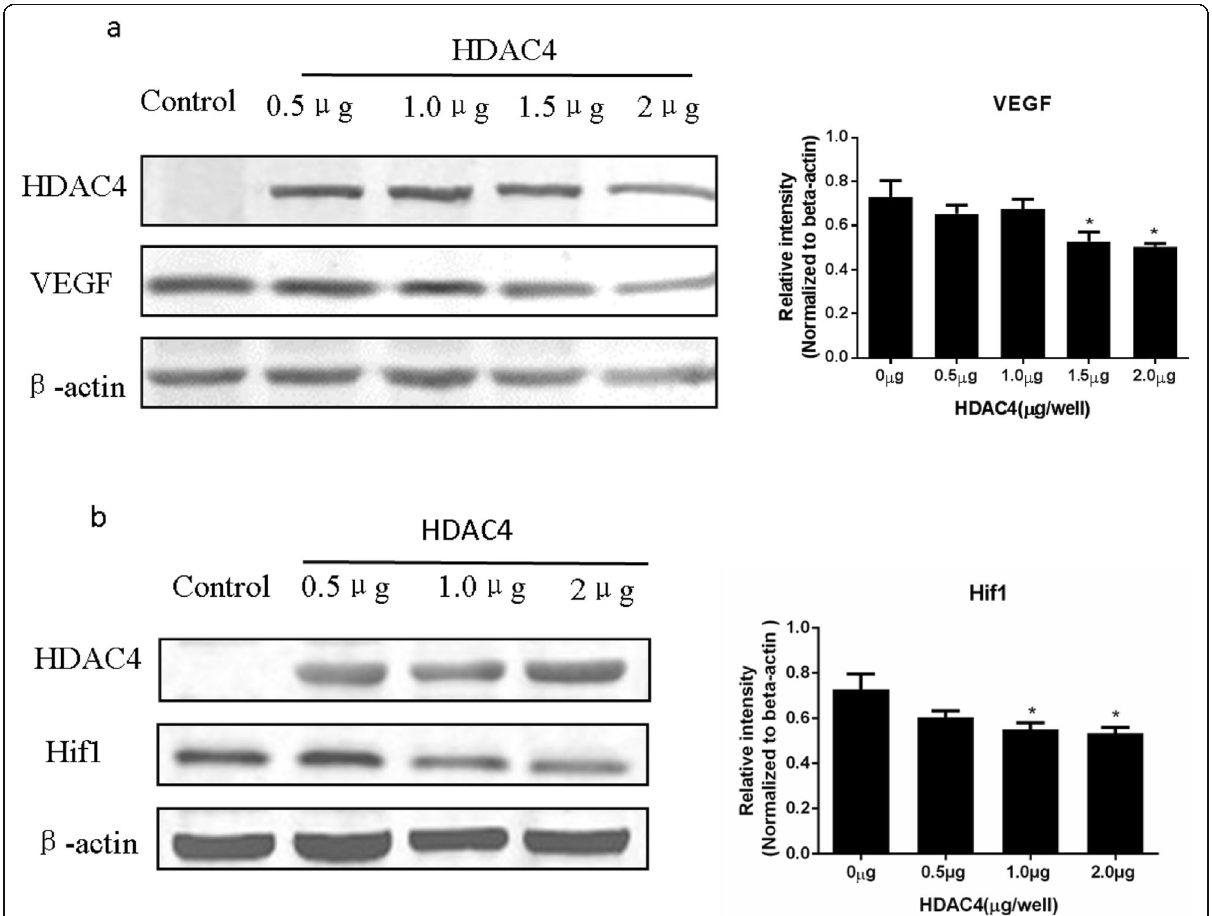
Fig. 5 Levels of HDAC4, VEFG, and Hif1 α following HDAC4 overexpression. a, b Expression levels of HDAC4, Hif1 α , and VEGF proteins were detected in Western blots following the transfection of various doses of GFP-HDAC4 DNA into isolated murine chondrocytes. Detection of β -actin was performed as a loading control. The accompanying bar graphs present the average relative intensity values for VEGF and Hif1 α , respectively, from three independent experiments. Data are expressed as mean ± SEM. * P < 0.05 vs. vehicle